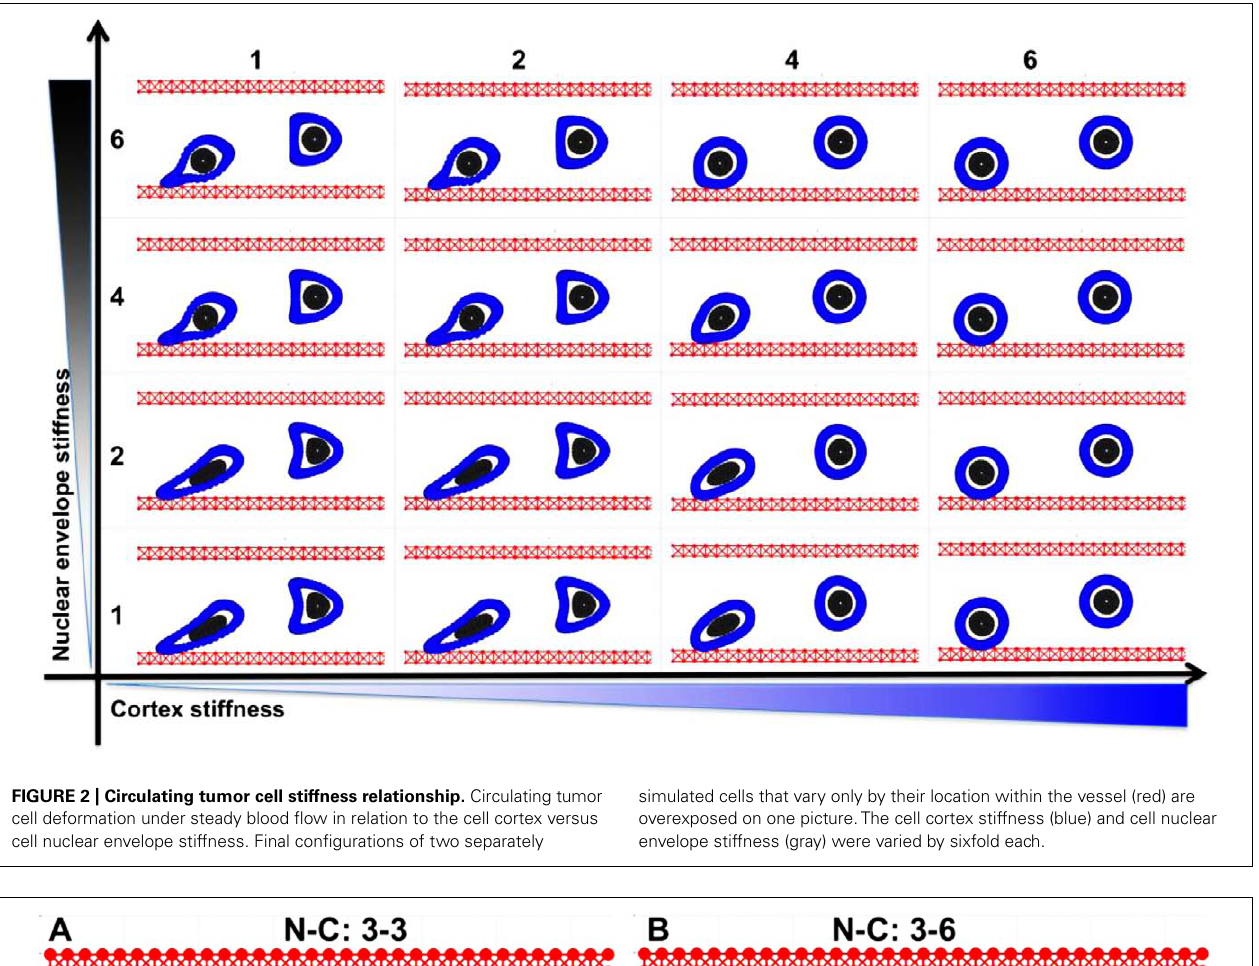
simulated cells that vary only by their location within the vessel (red) are overexposed on one picture.The cell cortex stiffness (blue) and cell nuclear envelope stiffness (gray) were varied by sixfold each.